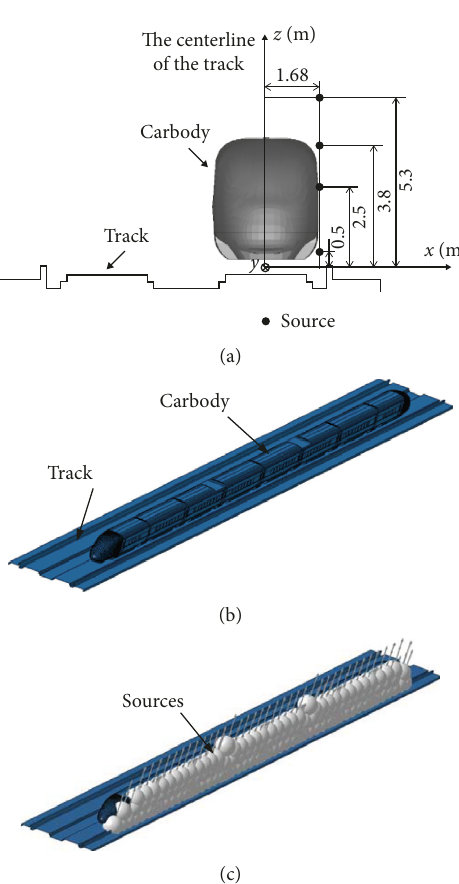
Figure 13: The exterior noise simulation model of a high-speed train. (a) Details of the source positions. (b) Whole train model. (c) Whole train model with sound sources.